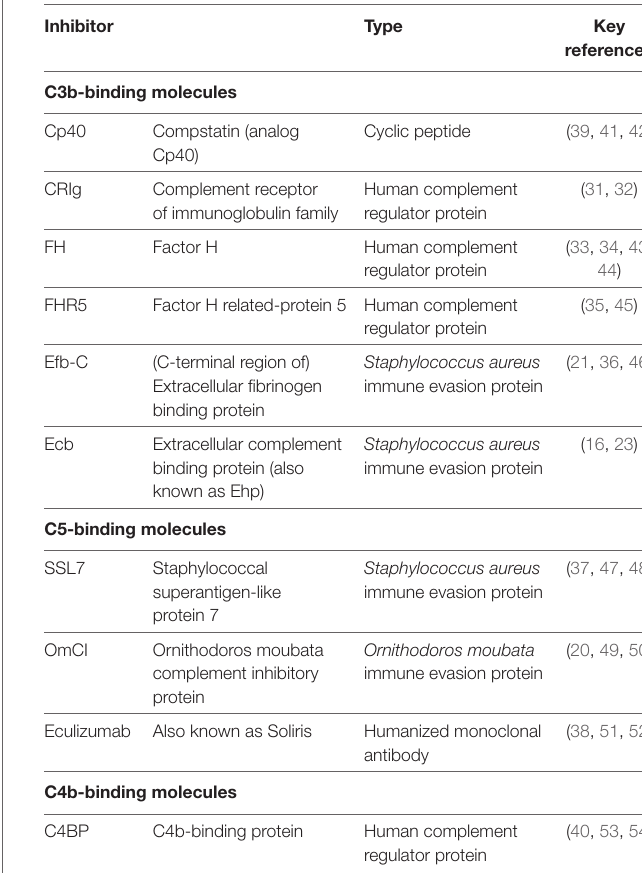
TaBle 1 | Overview of complement inhibitors used in this study.